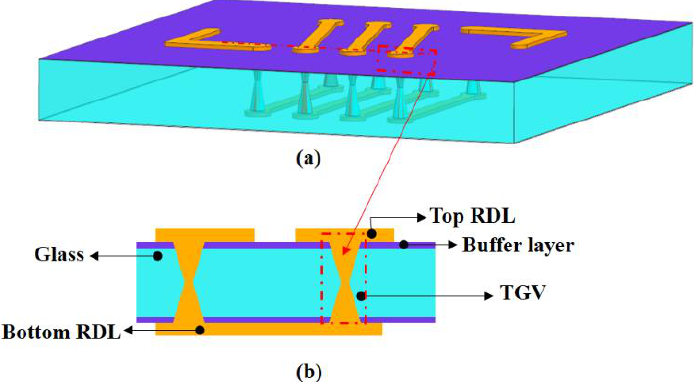
Figure 9. The 3D FE model. ( a ) FE model of A structure. ( b ) Cross-sectional image of A structure.